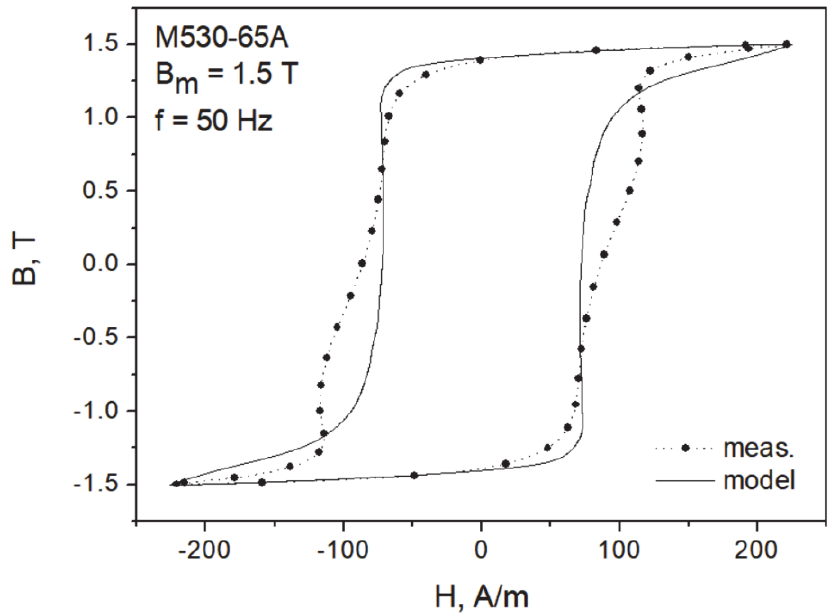
Figure 7. Measured and modeled hysteresis loop for Bm = 1.5 T, f = 50 Hz, M530 ‐ 65A grade.